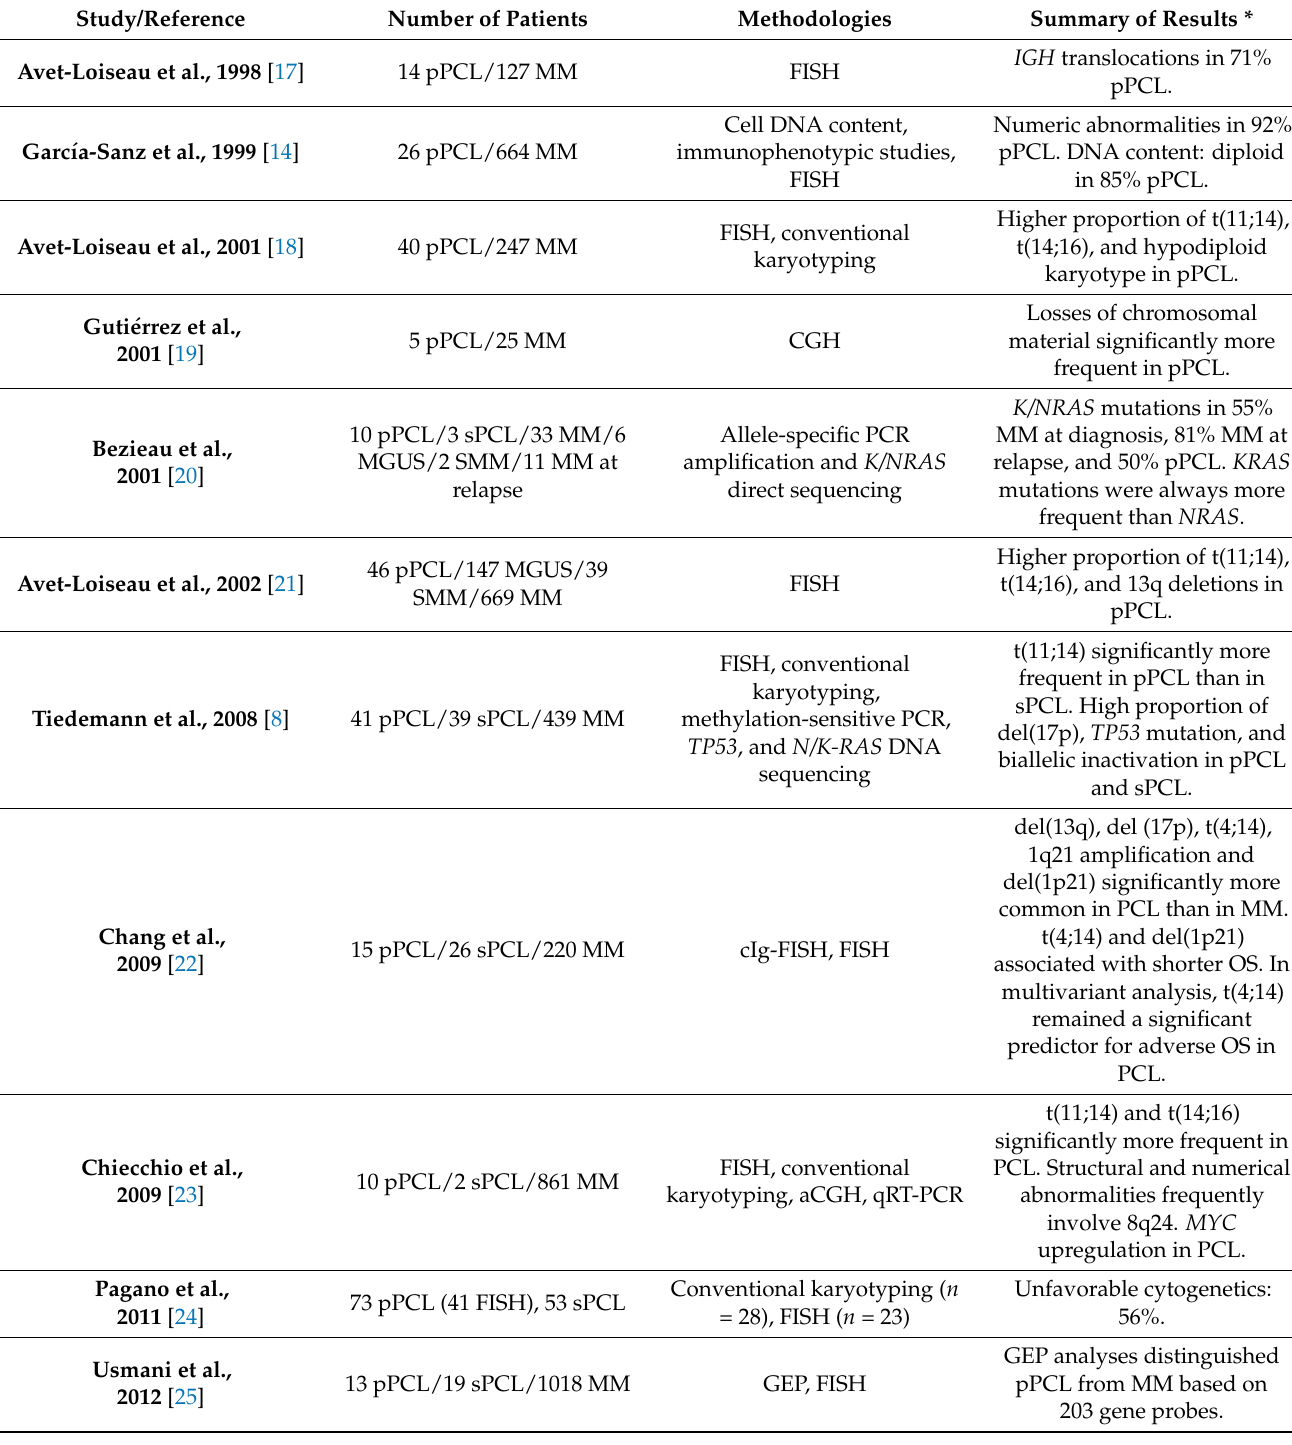
Table 1. Summary of the most relevant genomic studies carried out in